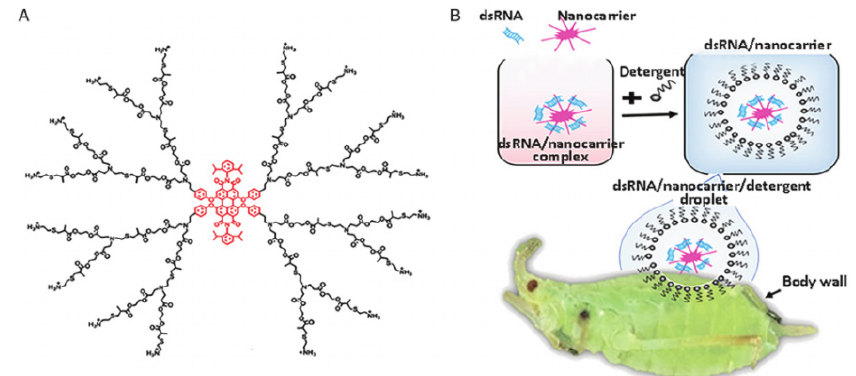
Figure 2. Schematic diagram of NCs-mediated delivery of dsRNA to control pests. ( A ) The chemical structure of the dendrimer nanocarrier and ( B ) The transdermal delivery system to enhance pesticidal effect of dsRNA. Reproduced with permission. (Adapted from Zheng Yang [33], with permission from the author).